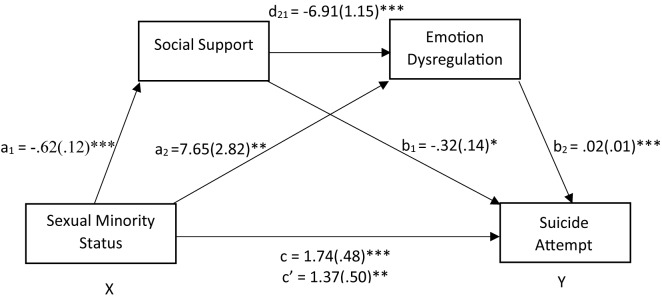
Social support and emotion dysregulation in sequence mediated the relationship between sexual minority status and suicide attempt. After adding the mediators, there is a significant indirect effect of sexual minority status on suicide attempt. The coefficients shown above are unstandardized. *Significant at the.05 level (2-tailed). **Significant at the.01 level (2-tailed). ***Significant at the.001 level (2-tailed).